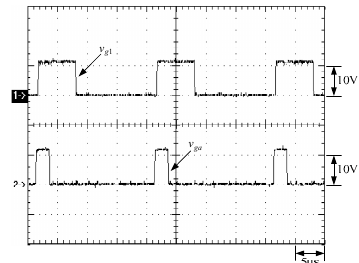
Figure 24. Waveforms pertaining to S 1 and S a at the rated load: (1) v g 1 ; and (2) v g 2 .